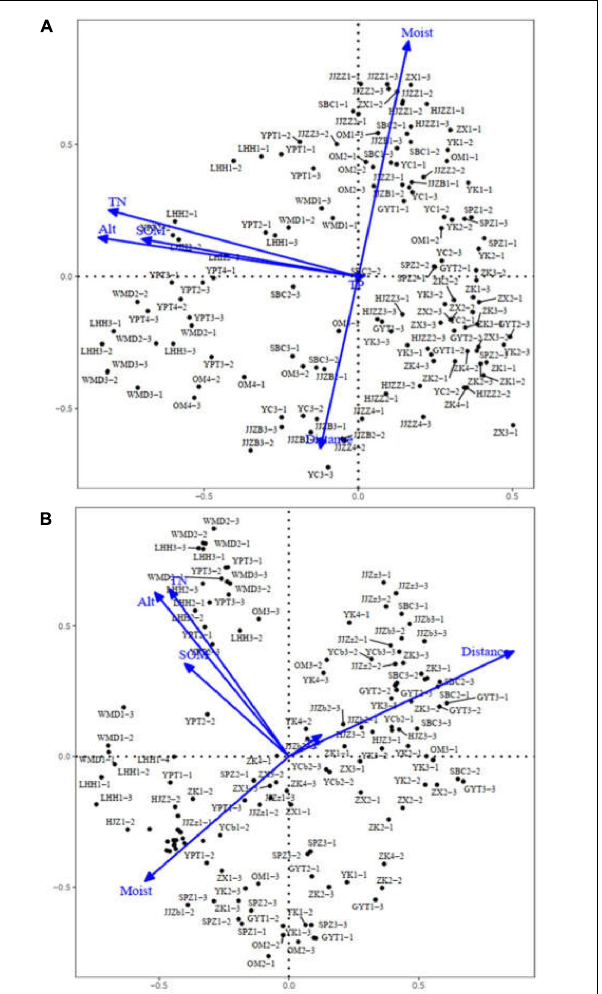
FIGURE 4 | Redundancy analysis (RDA) ordination diagrams of quadrats and environmental factors along the middle and lower reaches of the Hanjiang River. (A) RDA ordination diagram of 131 quadrats in June 2019; (B) RDA ordination diagram of 134 quadrats in October